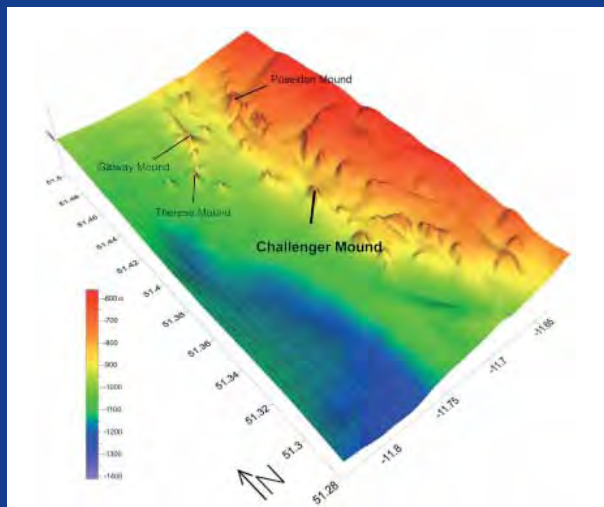
Figure 2. Multibeam bathymetry of Belgic mound province on eastern slope of Porcupine Seabight (after Beyer et al., 2003).